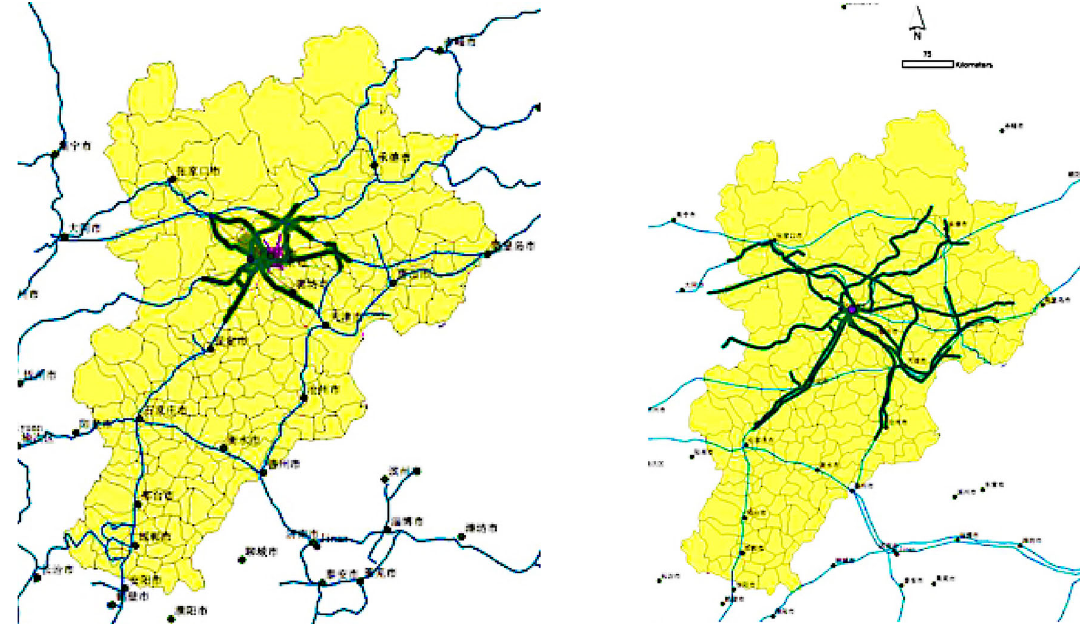
Fig. 3 Beijing Tianjin and Hebei region accessibility change from the county-level units ( left ) to high-speed rail ( right